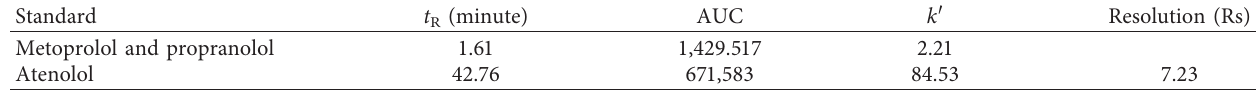
Figure 10: Chromatograms of atenolol (1) and its analogue (2) using the monolithic MIP 1 column. Table 10: Chromatographic profile of the β -blocker standard solution mixture. Standard